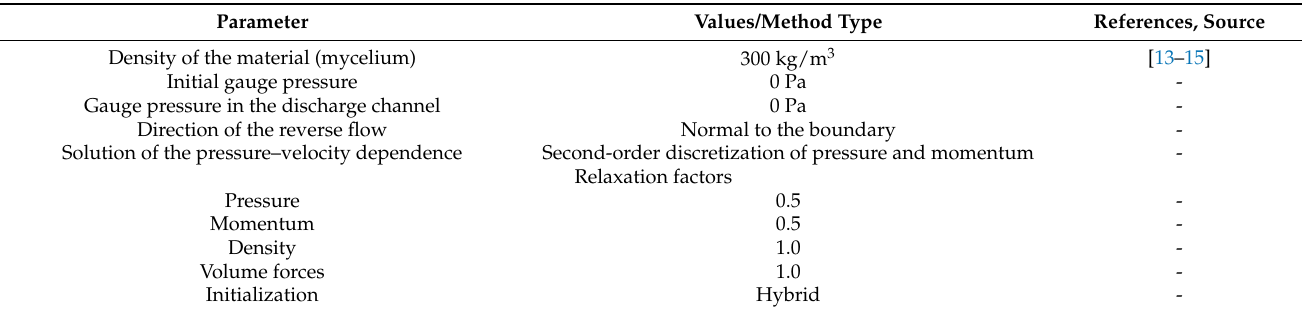
Table 1. Main model